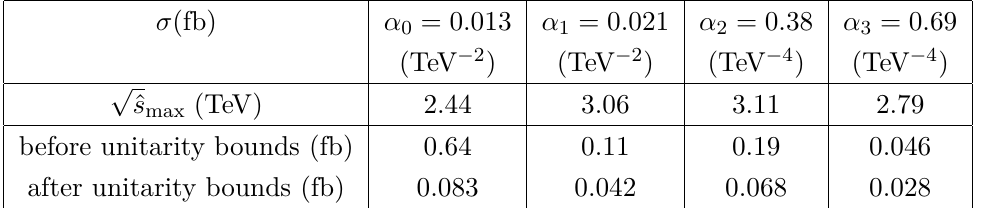
√ Table 4 . The ˆ s correspond to the largest coefficients in the ranges listed in table 1, and the max cross-sections before and after the energy cuts in eq.